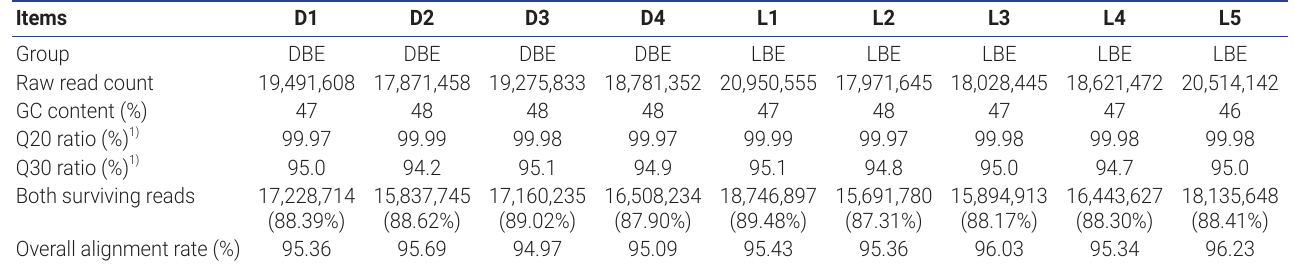
Table 2. Summary for sequence quality and alignment information of the liver samples